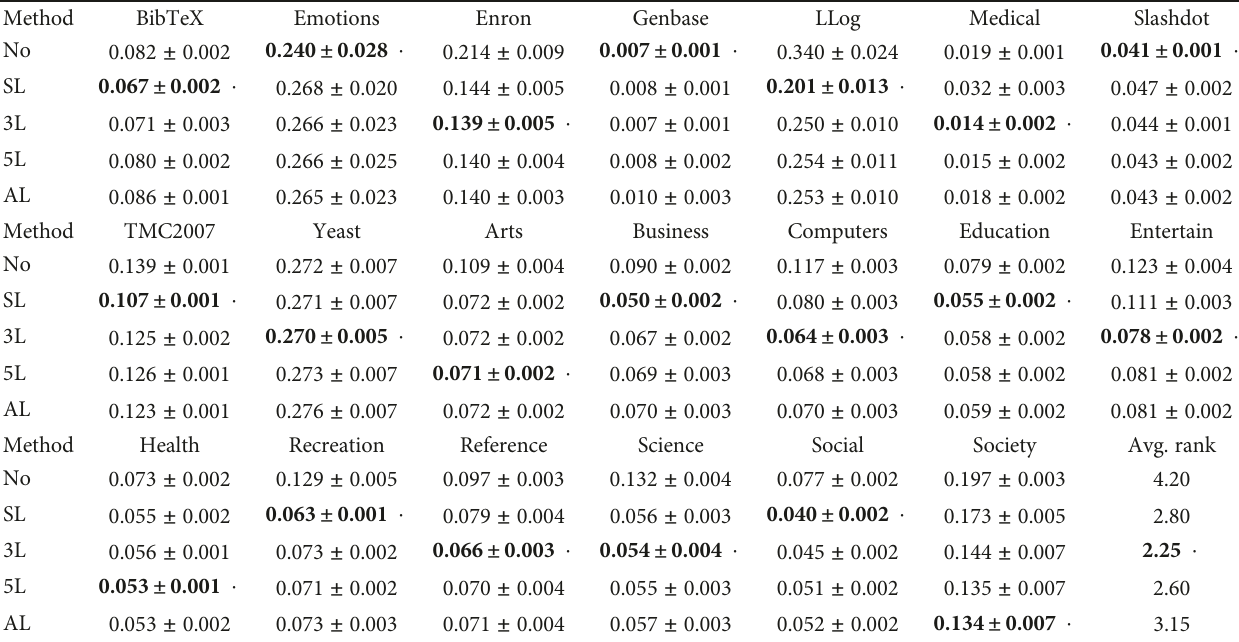
Table 3: Hamming loss ( ↓ ) performance of each comparing method (mean ± std. deviation) on 20 multilabel datasets.